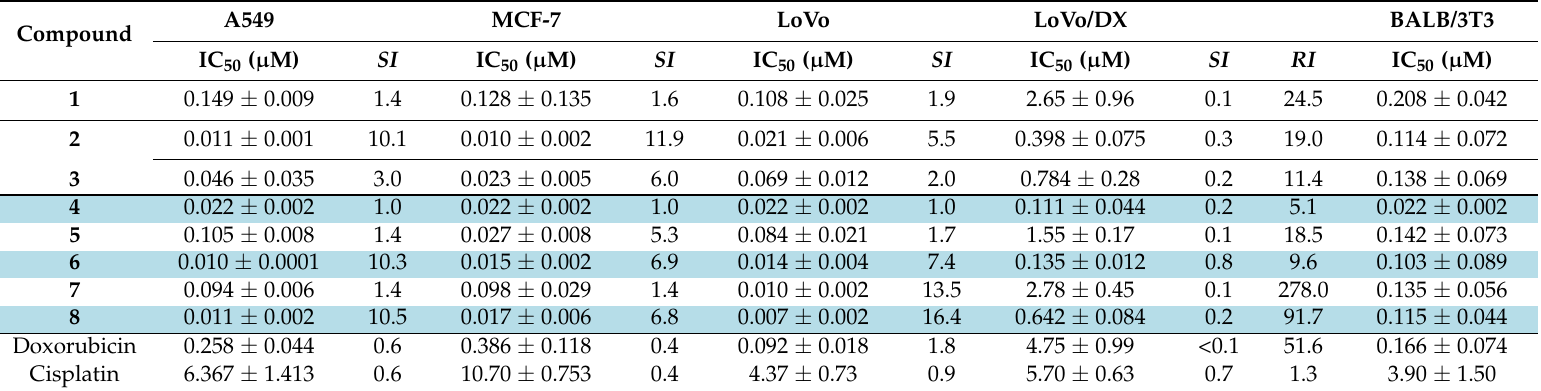
Table 1. Antiproliferative activity (IC 50 ) of colchicine ( 1 ) and its derivatives ( 2 – 8 ) compared with antiproliferative activity of standard anticancer drugs doxorubicin and cisplatin and the calculated values of the resistance index (RI) and selectivity index ( SI ) of tested compounds [19,39].